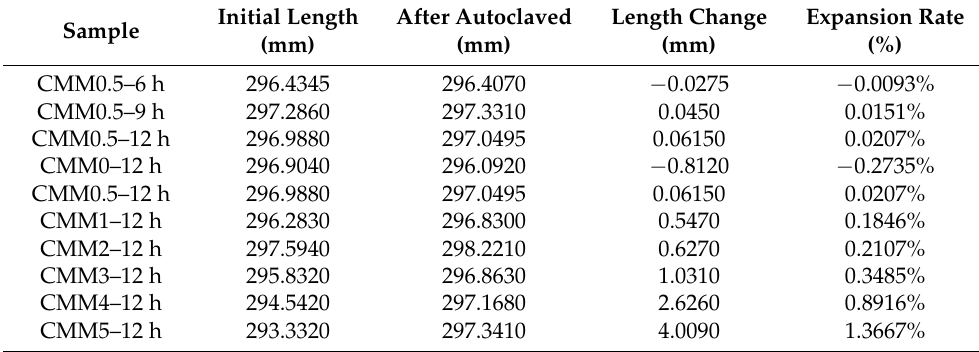
Table 4. CMM autoclaved test parameters.